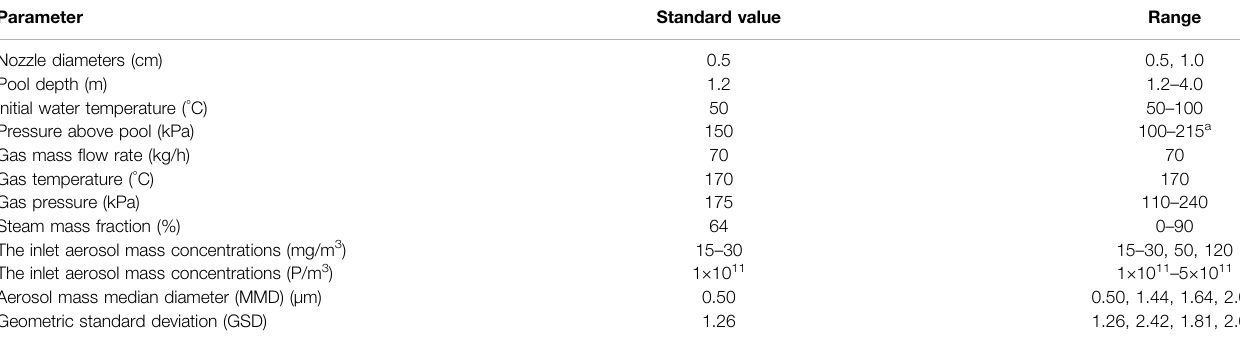
TABLE 2 | Small-scale aerosol pool scrubbing experimental test conditions.